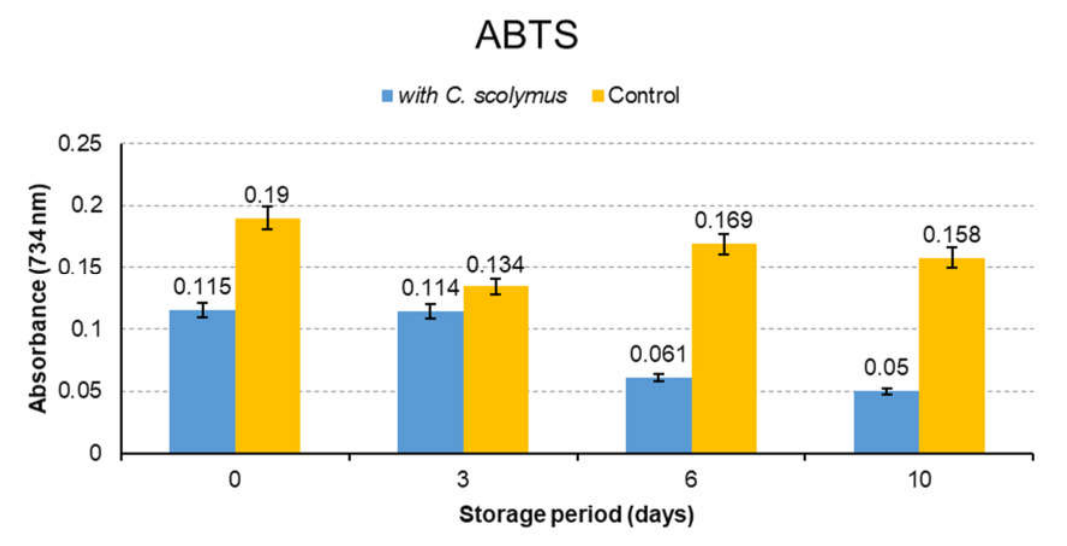
Figure 4. The antioxidant activity of control and marinated meat samples (ABTS assay).